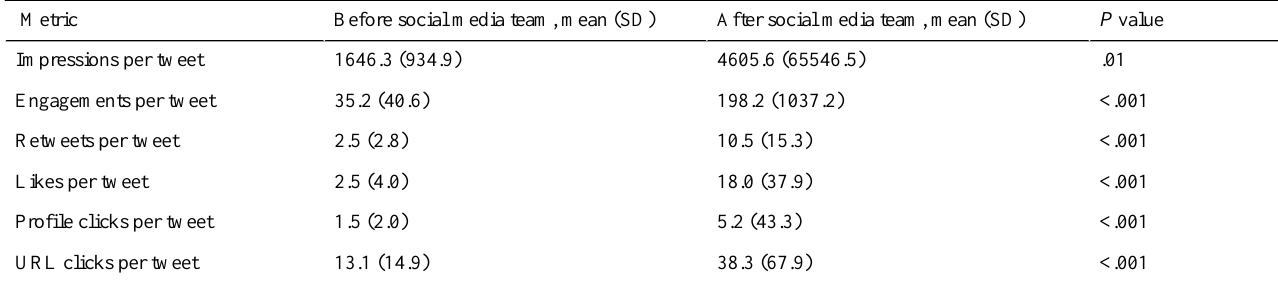
Table 1. Twitter analytics before and after creation of a social media team.